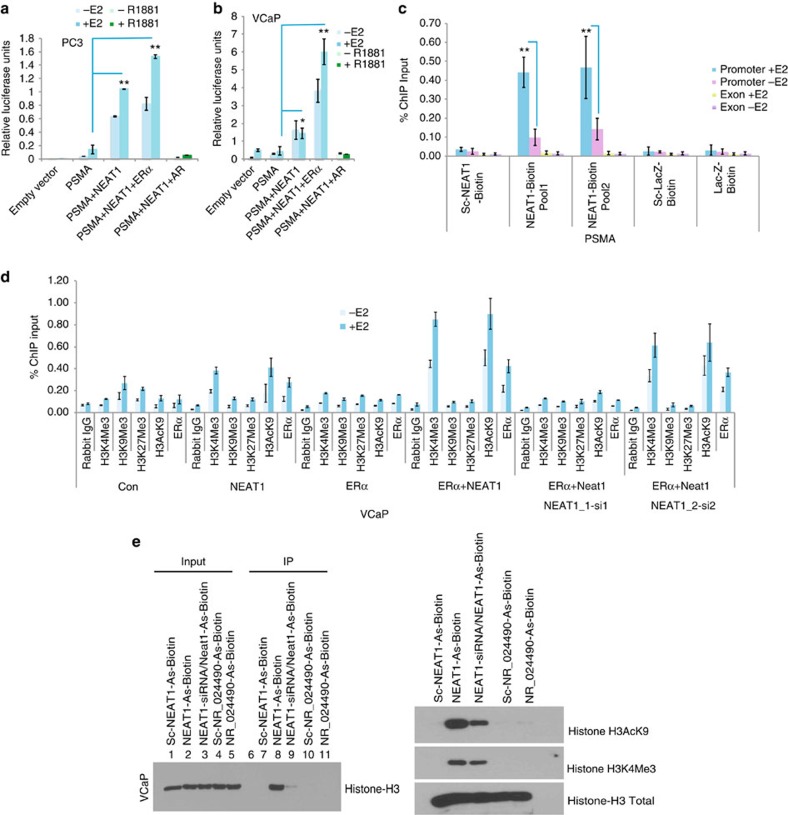
NEAT1 is a transcriptional regulator.(a,b) Promoter luciferase reporter assay shows that NEAT1 activates PSMA promoter in PC3 and VCaP cells. Cells were co-transfected with empty vector or PSMA luc and Renilla-luc reporter genes alone or with NEAT1, NEAT1+ERα and NEAT1+AR. Luciferase activity was measured 48 h post treatment with E2 (10 nM) or R1881 (1 nM). Results are expressed as the mean±s.d. calculated from three independent experiments. Student’s t-test was performed for comparisons (relative PSMA–luciferase activity) between −E2 and +E2 conditions for vector control, NEAT1 and NEAT1+ERα transfections in PC3 and VCaP cells. *P<0.05 and **P<0.01 were considered statistically significant. (c) Quantitative analysis of NEAT1 ChIRP in VCaP cells with or without E2 treatment (10 nM). Recruitment profiles of NEAT1 to PSMA are shown. Results are expressed as the percentage of input calculated from two independent experiments. Error bars represent the range of data. Results were reproducible between representative experiments. **P<0.01 was considered statistically significant. (d) Analysis of the chromatin landscape at the PSMA promoter performed by ChIP in VCaP cells alone or transected with NEAT1, ERα, NEAT1 ERα, NEAT1 ERα NEAT1_1 siRNA and NEAT1 ERα NEAT1_2 siRNA with and without E2 treatment. qPCR was performed with specific primers for the PSMA promoter. Results are expressed as the percentage of input calculated from two independent experiments. Error bars represent the range of data. Results were reproducible between representative experiments. (e) NEAT1 binds to Histone H3. 20 mer-biotinylated NEAT1 and NR_024490 antisense probes were used to immunoprecipitate NEAT1 and NR_024490 from nuclear lysates of VCaP cells using streptavidin magnetic beads. Immunoprecipitates from Streptavidin-IP were analysed on 15% gel and probed for Histone H3. NEAT1 is shown to also bind with active histone H3 modifications, including H3AcK9 and H3K4Me3.